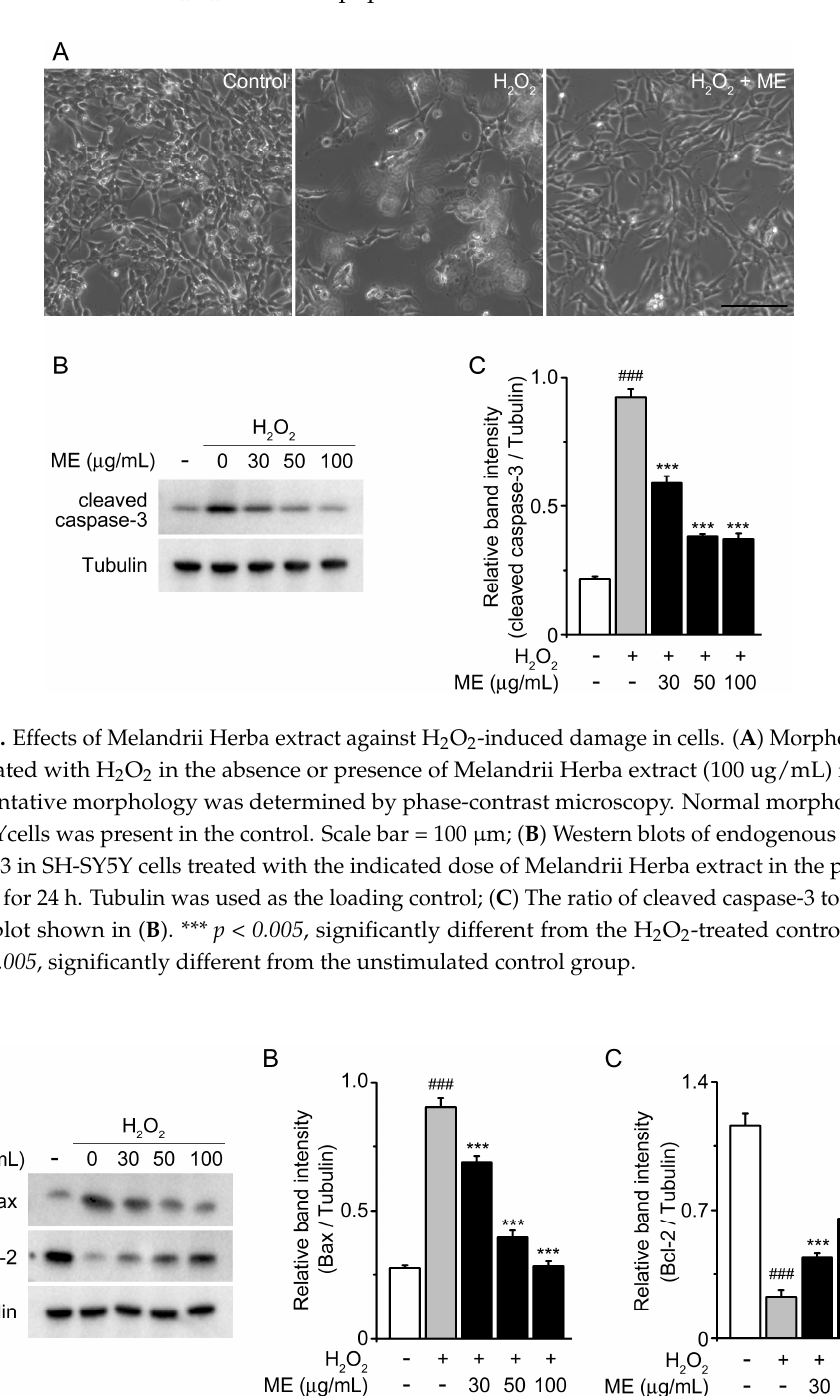
Figure 3. Effects of Melandrii Herba extract on the expression of Bax and Bcl-2 in H 2 O 2 exposed cells. ( A ) Western blots of endogenous Bax and Bcl-2 in SH-SY5Y cells treated with the indicated dose of Melandrii Herba extract in the presence of H 2 O 2 for 24 h. Tubulin was used as the loading control; ( B ) The ratio of Bax to tubulin; ( C ) The ratio of Bcl-2 to tubulin for the blot shown in ( A ). *** p < 0.005 , significantly different from the H 2 O 2 -treated control group. ### p < 0.005 , significantly different from the untreated control group.